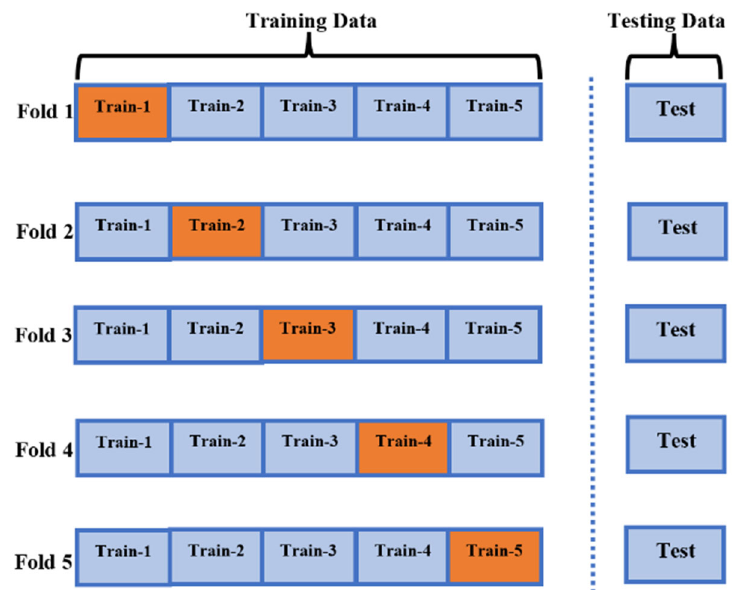
Figure 1. Diagram of the five ‐ fold cross ‐ validation.